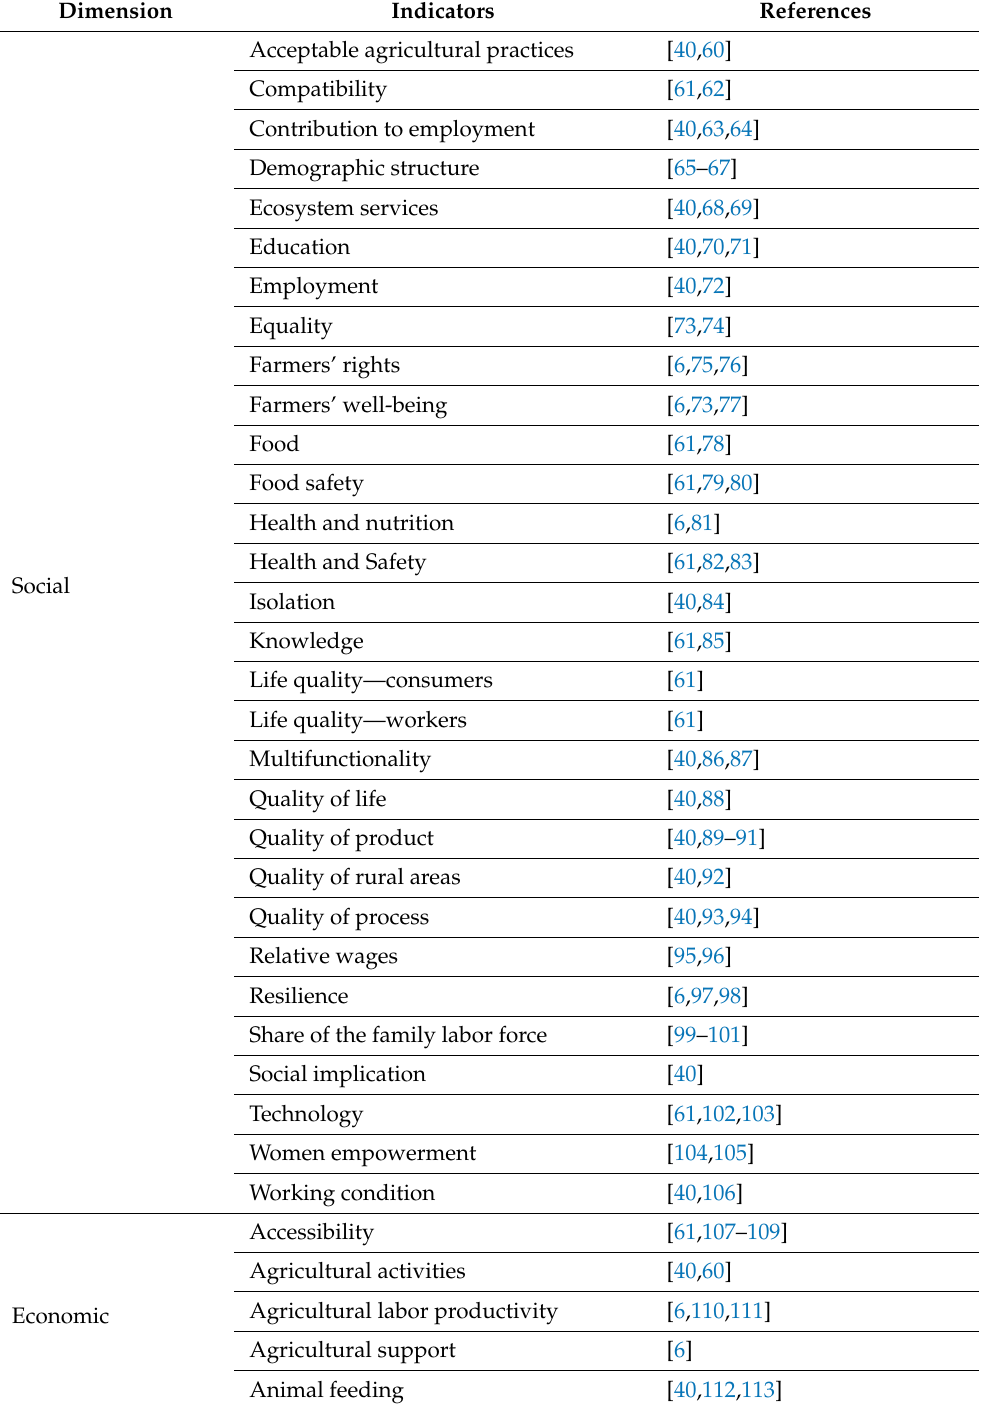
Table 2. Indicators of sustainable